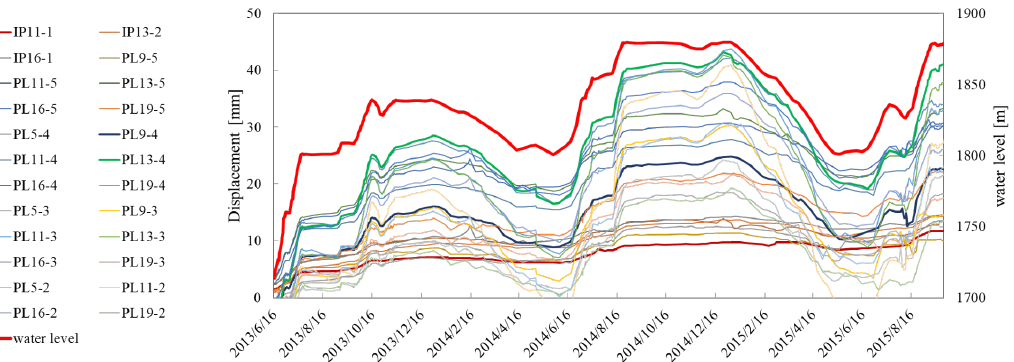
Figure 6. Time evolution of water level and radical displacement (to the downstream is positive) of each measuring point (data provided by Jinping I hydropower station with